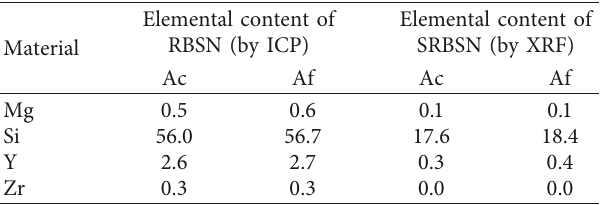
T ABLE 2: Analysis of elemental contents for both RBSN and SRBSN.